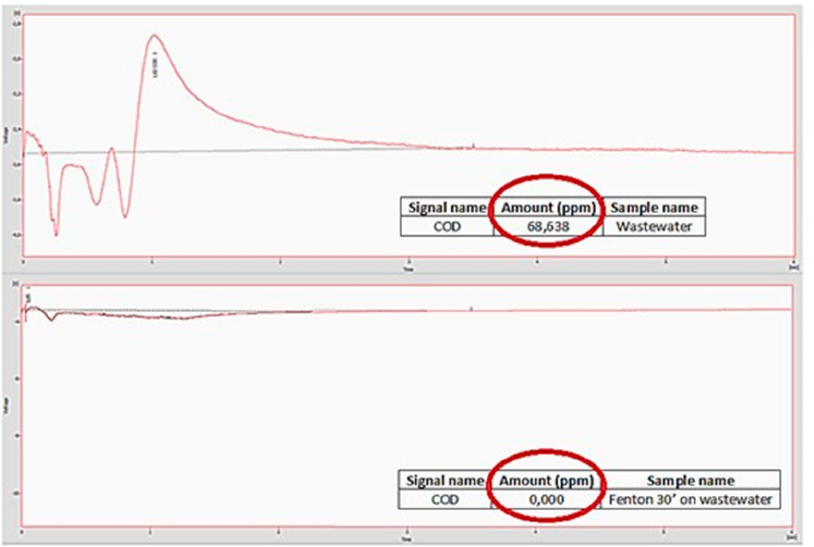
Figure 6. Comparison between COD of wastewater ( top ) and COD of wastewater after treatment with Fenton reagent after 30 min ( bottom ).